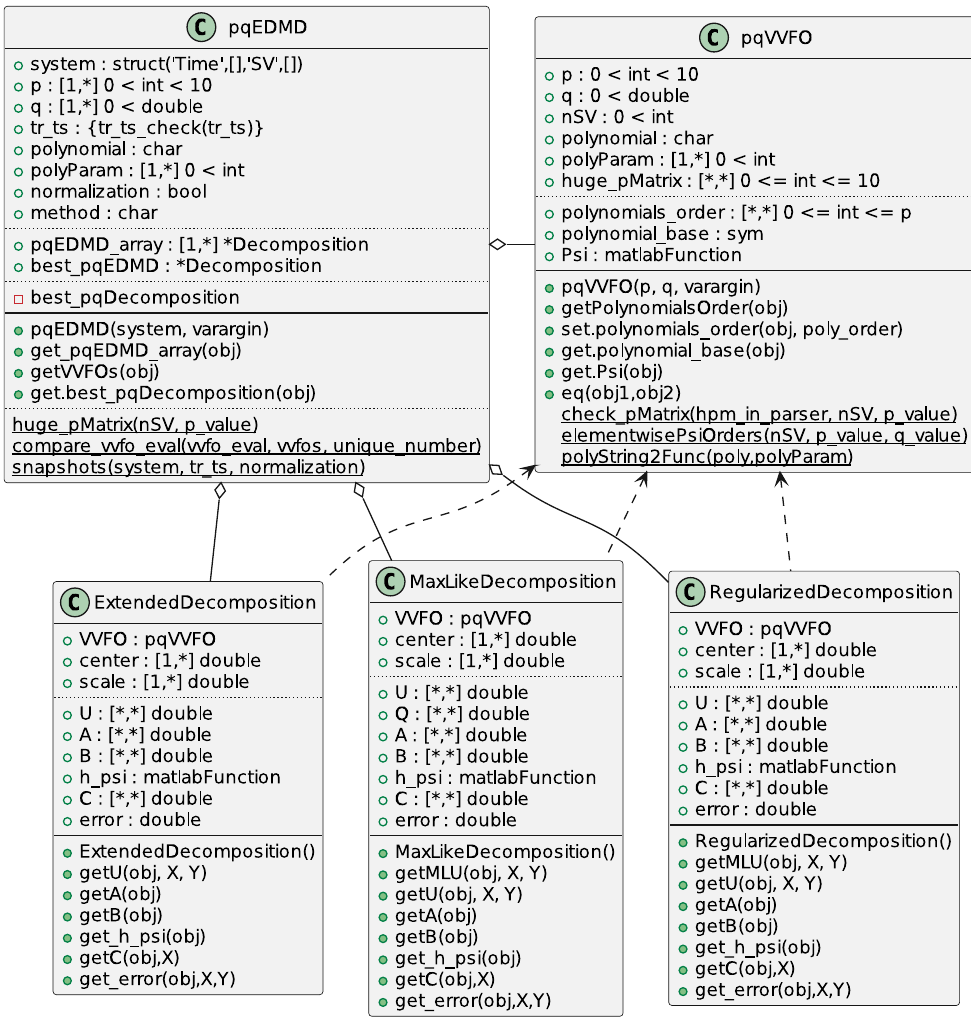
Figure 5. Package architecture.